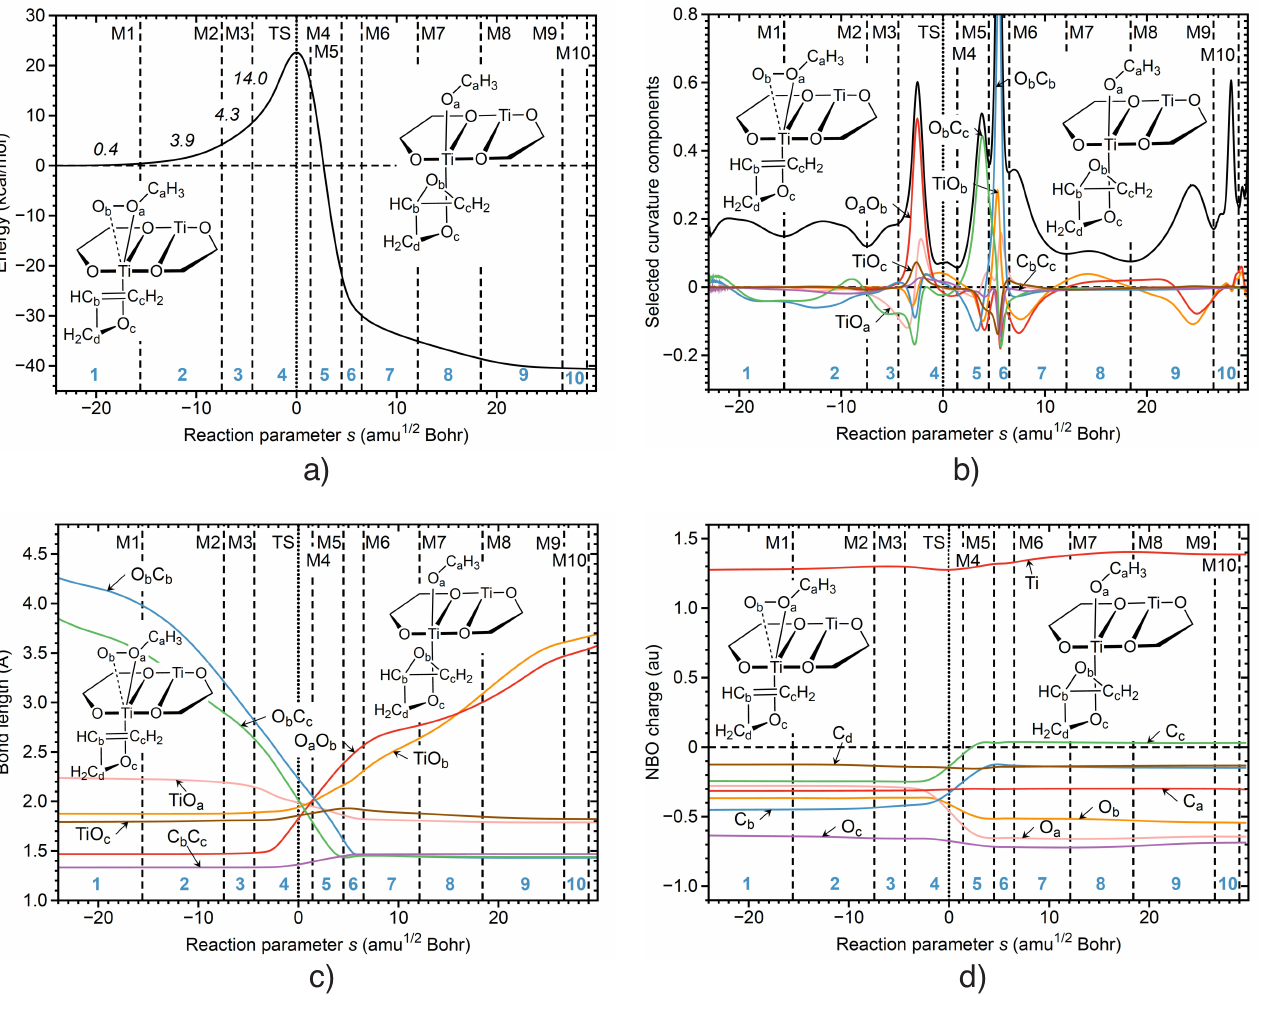
d) Figure 5. Properties of reaction R2 along the reaction path. ( a ) The energy profile, where the energy contributions of each reaction phase to the activation energy are indicated by italic numbers. ( b ) Decomposition of the reaction curvature into selected chemical bonds. ( c ) The change of the selected bond lengths. ( d ) The change of the selected NBO atomic charges. The curvature minima are shown as broken vertical lines and are labeled as M1, M2 and so on. The position of TS is indicated as a dotted line. The reaction phases are indicated by blue numbers. B3LYP/6-31G(d,p)/SDD(Ti) level of